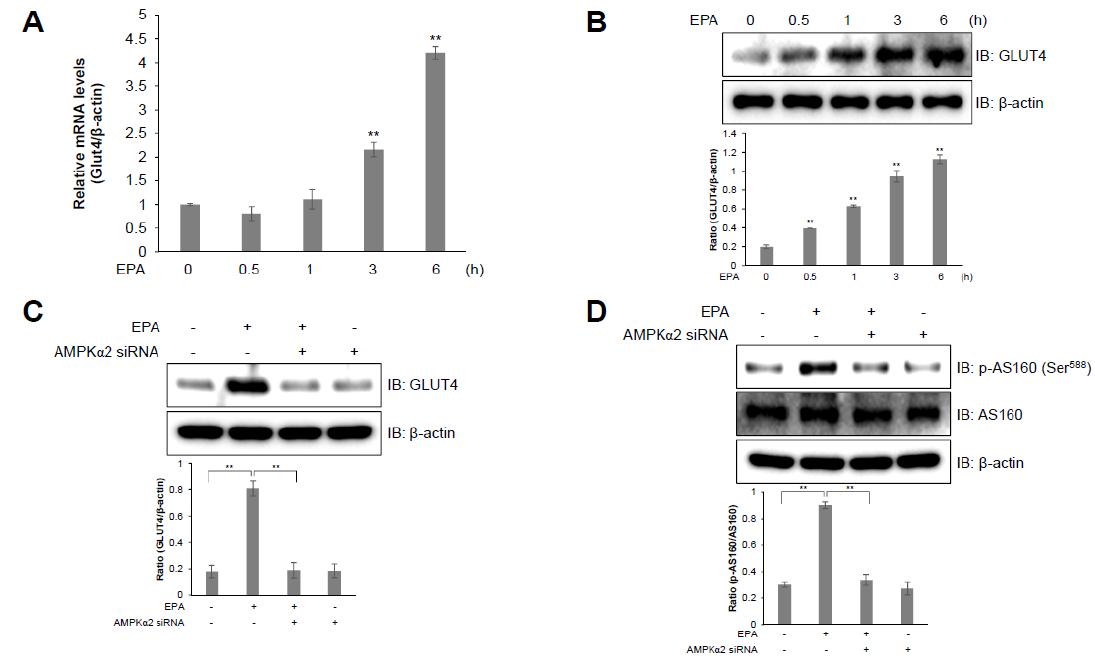
Figure 5. AS160 is involved in EPA-induced GLUT4 expression in C2C12 myoblasts. ( A ) GLUT4 and β-actin transcripts measured by RT-qPCR from EPA-treated C2C12 cells. ( B ) Western blot analysis of GLUT4 and β-actin levels in cells stimulated with 50 μM EPA for the indicated times. The levels of β-actin are presented as a loading control. ( C ) Western blot analysis of cell lysates from cells transfected with AMPK α 2 siRNA (100 nM) for 2 days and then treated with EPA. ( D ) p-AS160, AS160, and β -actin expression quantified using western blot analysis in cells transfected with AMPK α 2 siRNA and treated with EPA. ** p < 0.01 compared to the basal condition. Results from three independently replicated experiments are presented.